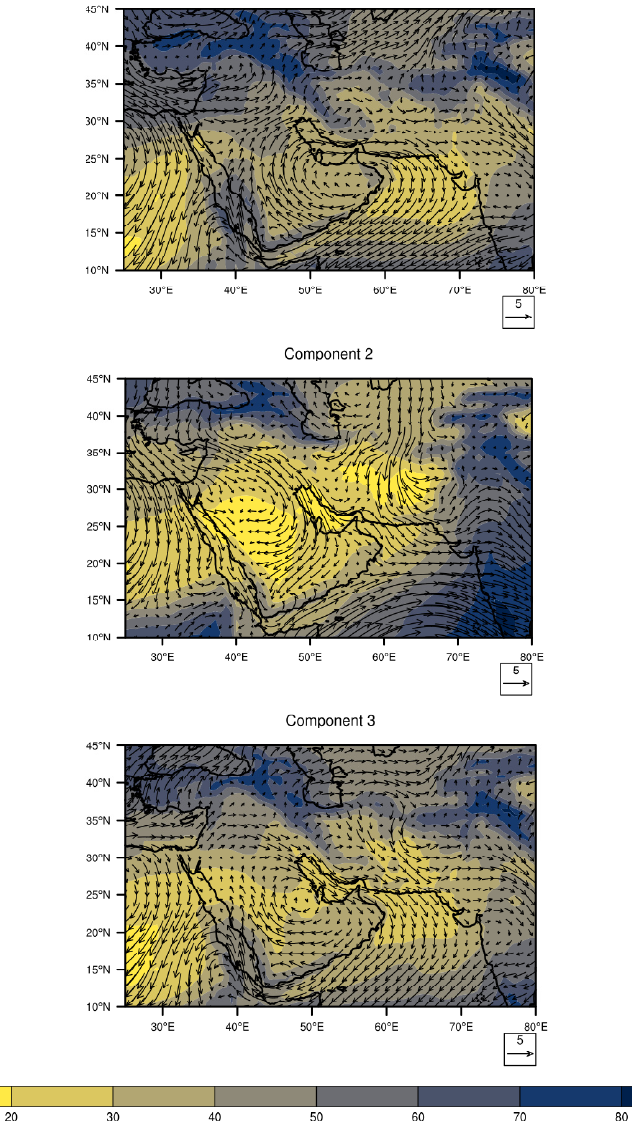
Figure 10. Mean relative humidity at 850 hPa and wind vectors (m / s) at 850 hPa associated with each distribution component, derived from ERA-Interim (2005–2017). Arrows indicate direction and magnitude of winds. Kuwait is shown with a white